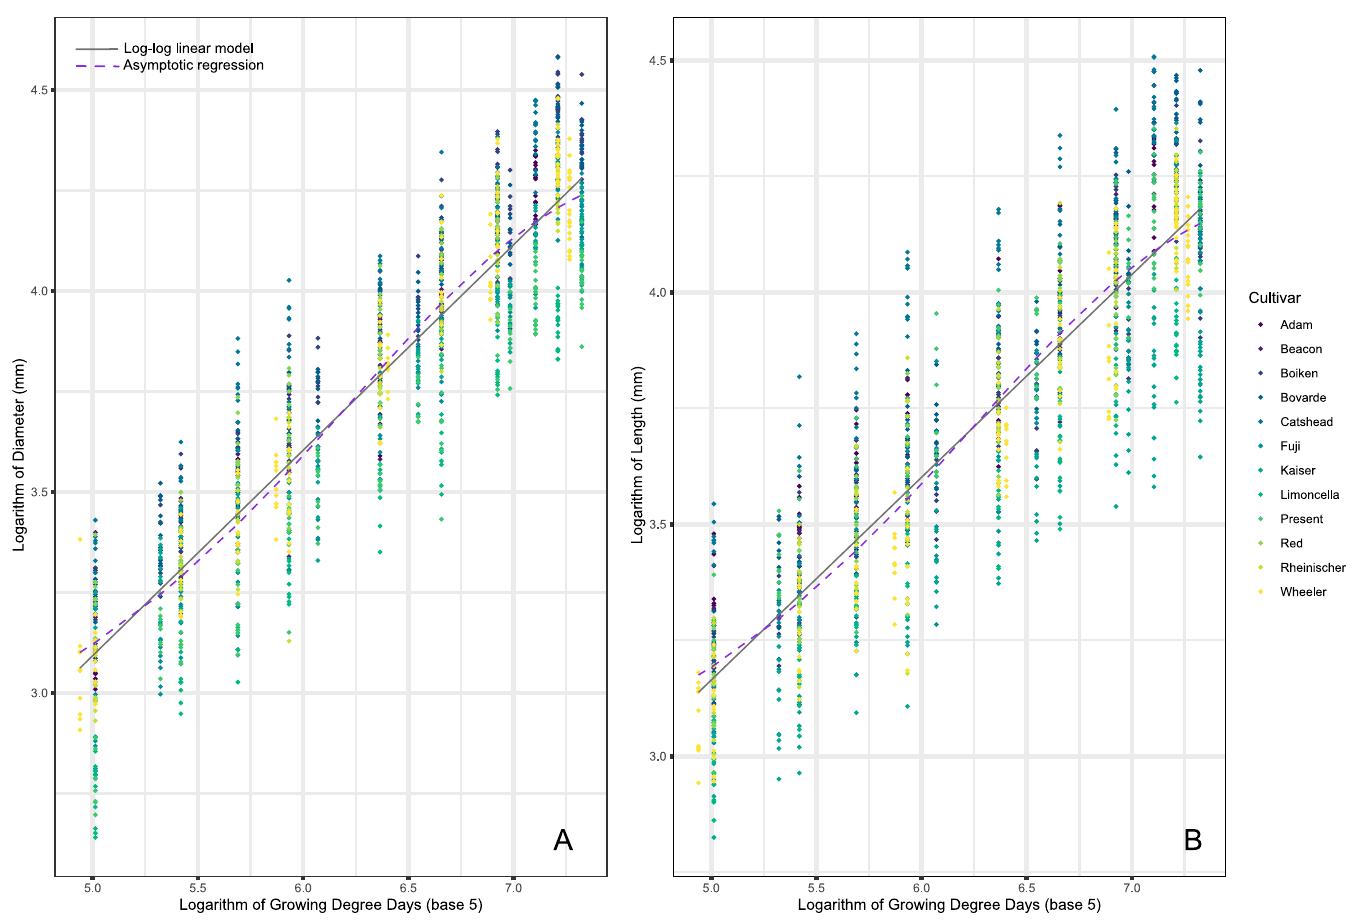
Fig 1. Model fit for log-log linear regression (solid grey) and asymptotic regression (dashed purple) between growing degree days and measured morphometrics (A: Diameter, B: Length). Twelve apple cultivars were sampled throughout the 2013 growing season, with six of them repeated in the 2014 growing season. Both growing degree days and respective morphometrics are logarithmically transformed for illustration purposes. Growing degree days are base 5.